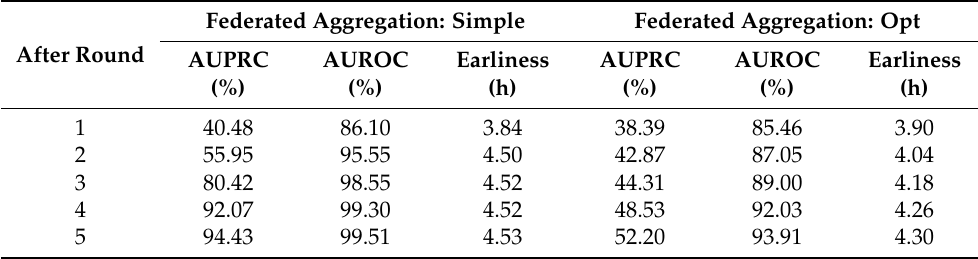
Table 12. Evaluation results using non-text input features in a federated learning setting using three Jetson Nano